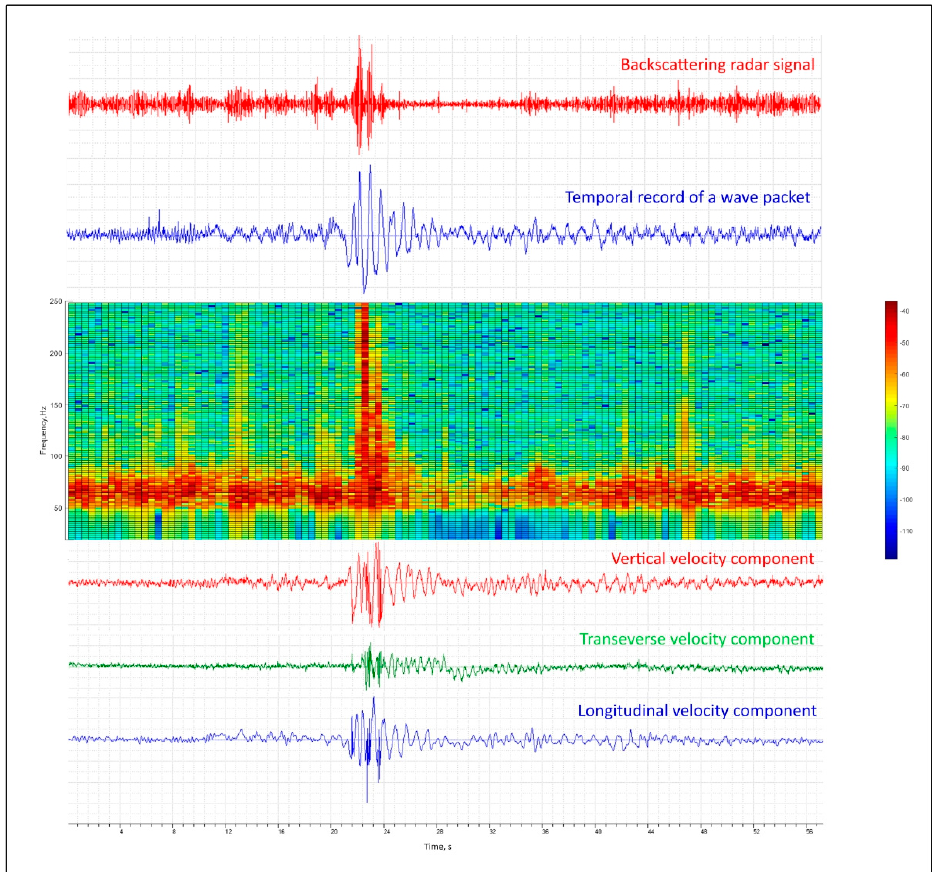
Figure 9. An example of time series of the radar backscatter and surface elevation (top panel, red and green lines, respectively), the radar Doppler spectrogram (center panel), and three components of flow velocities in the upper water layer (bottom panel).